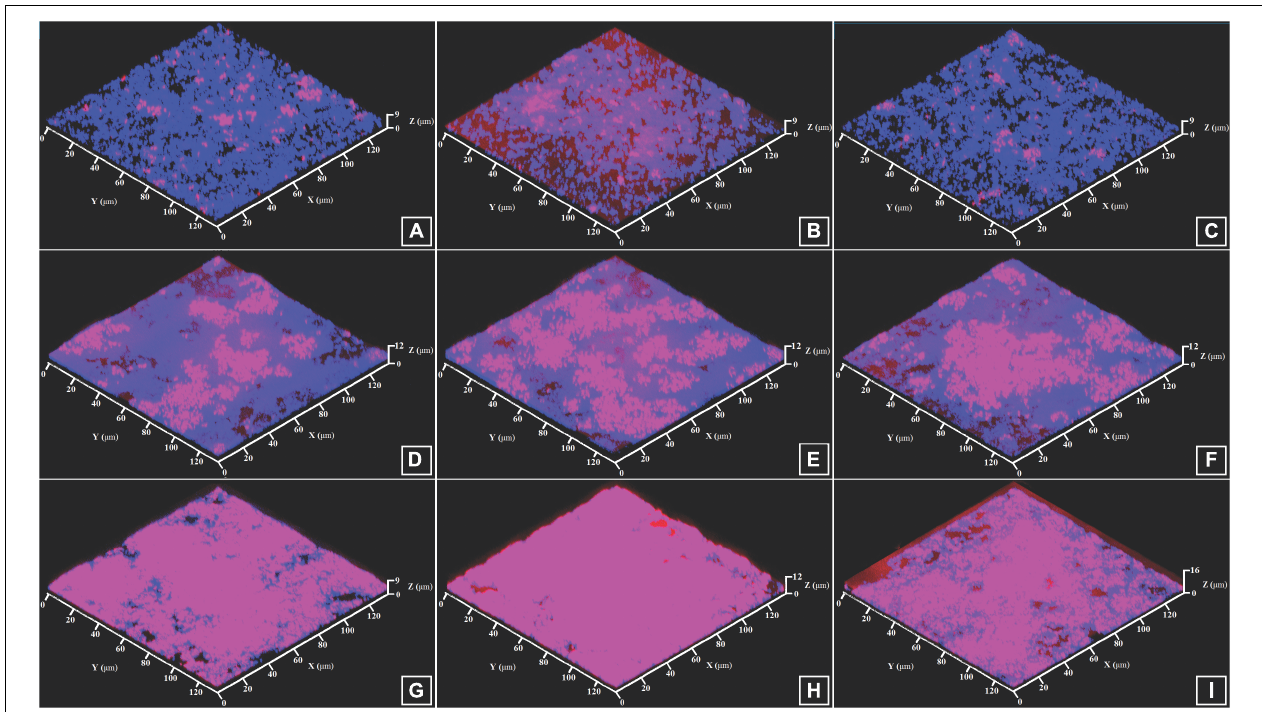
FIGURE 7 | CLSM images of FISH-labeled mixed biofilms of S. aureus MFP03 and C. acnes RT5. (A) Simultaneously grown biofilm, Control; (B) Simultaneously grown biofilm, ANP 10 − 8 M; (C) Simultaneously grown biofilm, CNP 10 − 7 M; (D) Biofilm based on pre-formed S. aureus MFP03 biofilm, Control; (E) Biofilm based on pre-formed S. aureus MFP03 biofilm, ANP 10 − 8 M; (F) Biofilm based on pre-formed S. aureus MFP03 biofilm, CNP 10 − 7 M; (G) Biofilm based on pre-formed C. acnes RT5 biofilm, Control; (H) Biofilm based on pre-formed C. acnes RT5 biofilm, ANP 10 − 8 M; (I) Biofilm based on pre-formed C. acnes RT5 biofilm, CNP 10 − 7 M. Pink, C. acnes RT5 FISH labeling; Blue, DAPI staining (total biomass).